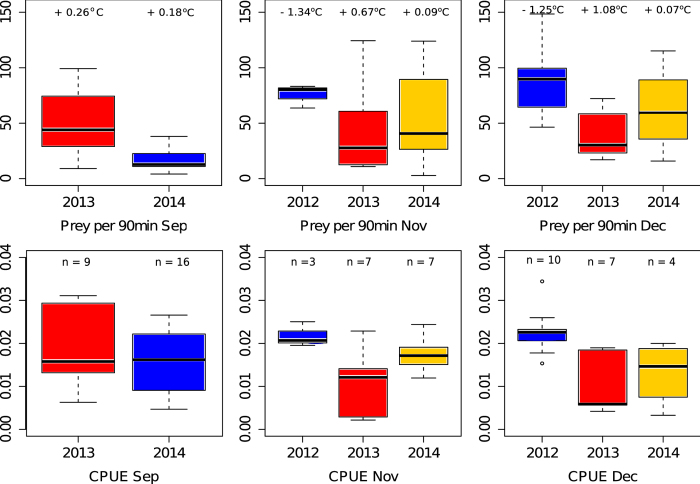
Mean prey caught per 90 min window and mean CPUE (prey caught per minute spent diving below 1.5 m) per 90 min window by month in 2012, 2013 and 2014.Box plots are coloured according to the SST relative to the mean SST of that month in the other two study years (red being the warmest of the 3 years for each month, blue being the coldest). Sample size and deviation from the mean monthly temperature (oC) are noted on the prey capture plot (top row) and samples sizes are shown on the CPUE plot (bottom row).